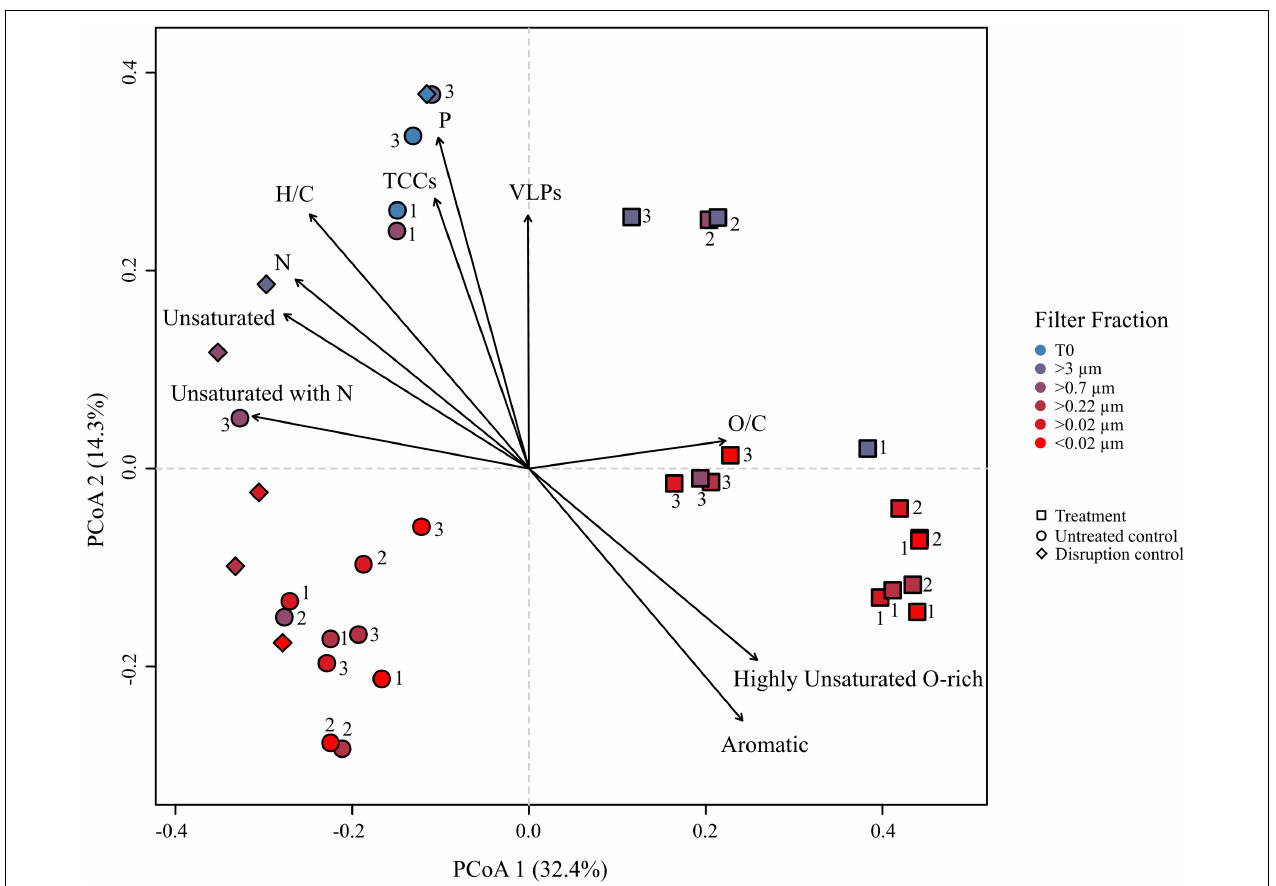
FIGURE 5 | Principal coordinate analysis (PCoA) based on Bray–Curtis dissimilarities of the relative abundances of molecular formulae from the R. sulfidophilum culture incubations. Squares indicate mitomycin C treated cultures (‘treatments’), circles the untreated controls and diamond shapes the disruption controls. Each sample was filtered over several filters as indicated by the color code. Biological replicates are indicated by the numeration 1–3. Significant experimental meta-data and molecular parameters ( p < 0.05) were fitted to the ordination (black